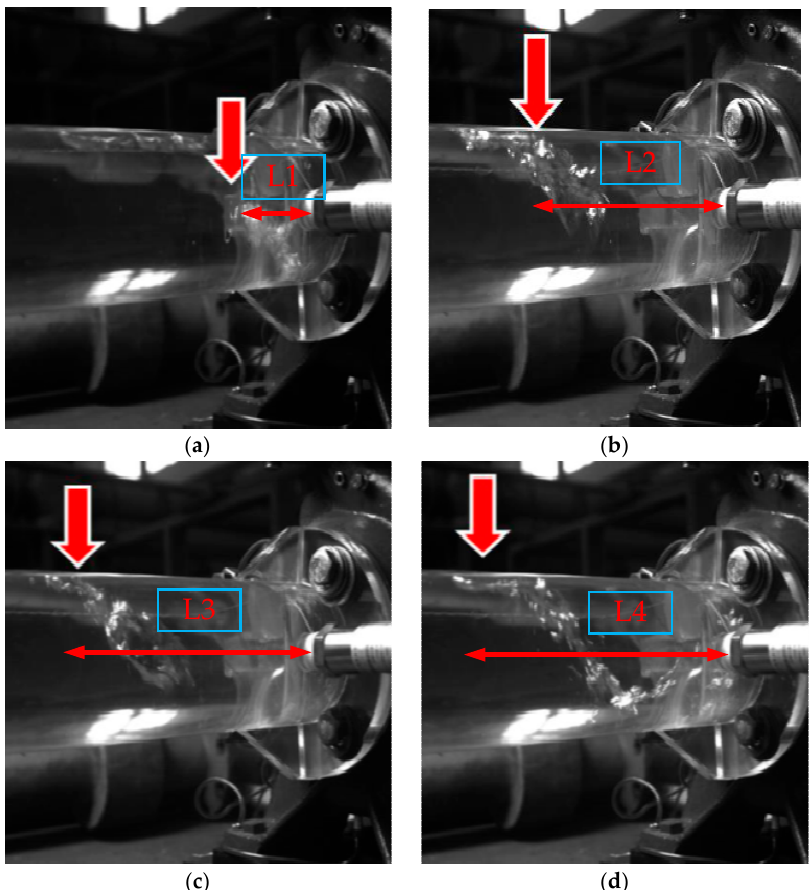
Figure 15. PSD of the acoustic pressure measured by pump inlet hydrophone 2 at different flow rates. ( a ) 0–400 Hz; ( b ) 1–10 kHz.